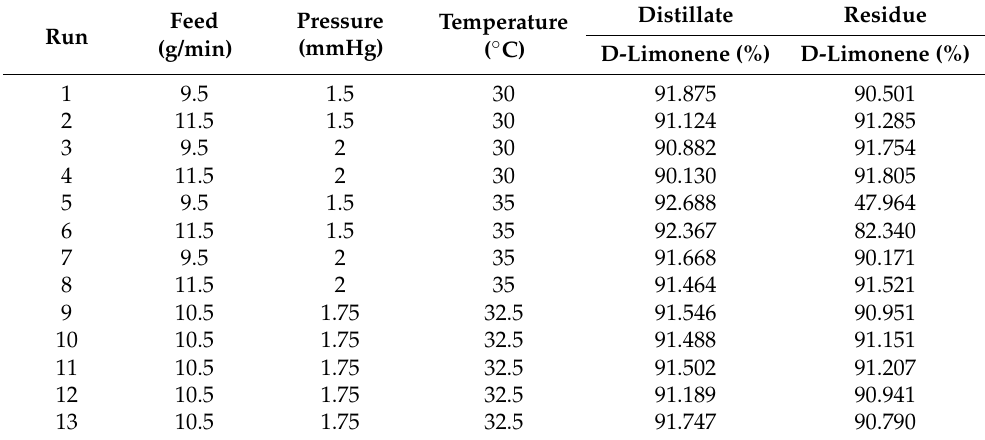
Table 3. Results of D-Limonene percentage according to factorial design of molecular distillation.